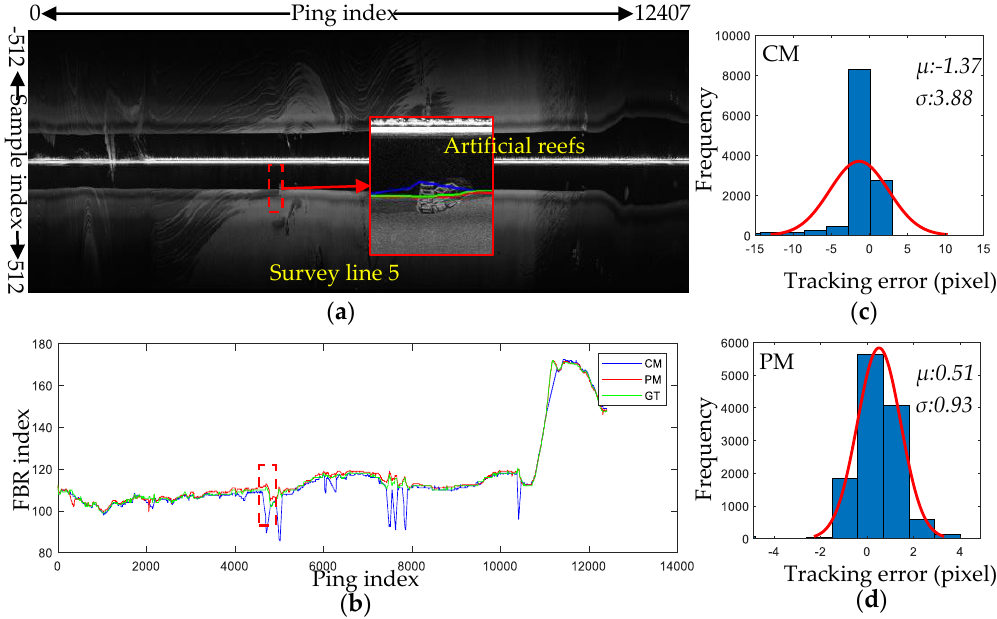
Figure 16. Bottom tracking experiment on the SSS data with artificial architecture. ( a ) Waterfall image re-quantized from raw SSS data. ( b ) Averaged bottom tracking results of port and starboard with the tow methods. ( c , d ) Error distribution relative to the manual interpretation.